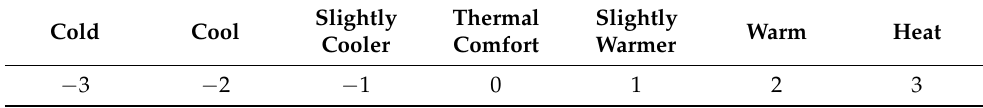
Table 8. Indoor thermal comfort index for PMV in the range −